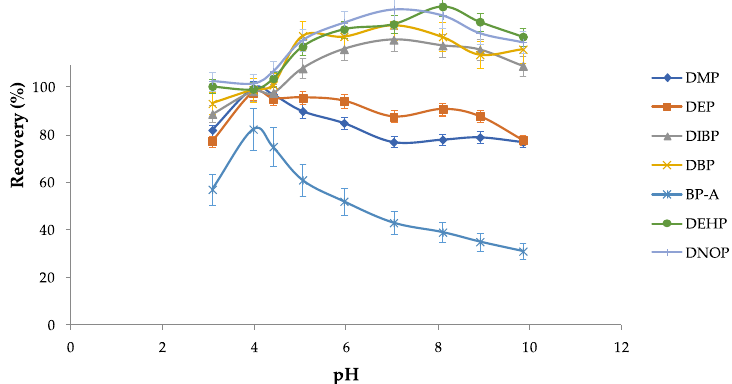
Figure 1. E ff ect of the pH on the recoveries of PAEs / BP-A investigated in this study. The conditions Figure 1. Effect of the pH on the recoveries of PAEs/BP-A investigated in this study. The conditions were as follows: each PAE / BP-A at 50 ng mL − 1 , 150 µ L of toluene, 10 g L − 1 of NaCl, and 6 min were as follows: each PAE/BP-A at 50 ng mL −1 , 150 μL of toluene, 10 g L −1 of NaCl, and 6 min of of ultrasounds.